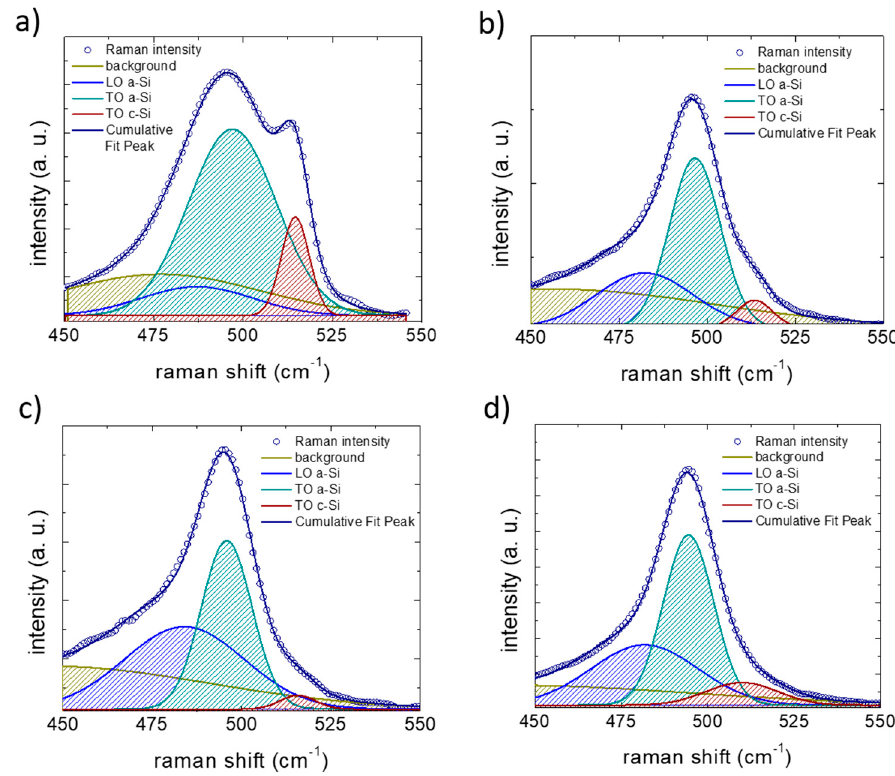
Figure 5. Examples of Raman spectra fit for spectra collected after five lithiation–de-lithiation cycles in ( a ) on pristine Si NW anode, ( b ) Si NW anode cycled with 1M LiPF 6 electrolyte, ( c ) added with 3% of fluoroethylene carbonate (FEC) or ( d ) added 3% of vinylene carbonate (VC). The resulting Raman maps have been obtained from the ratio between the areas of amorphous silicon TO peak (green) and crystalline silicon TO peak (red).